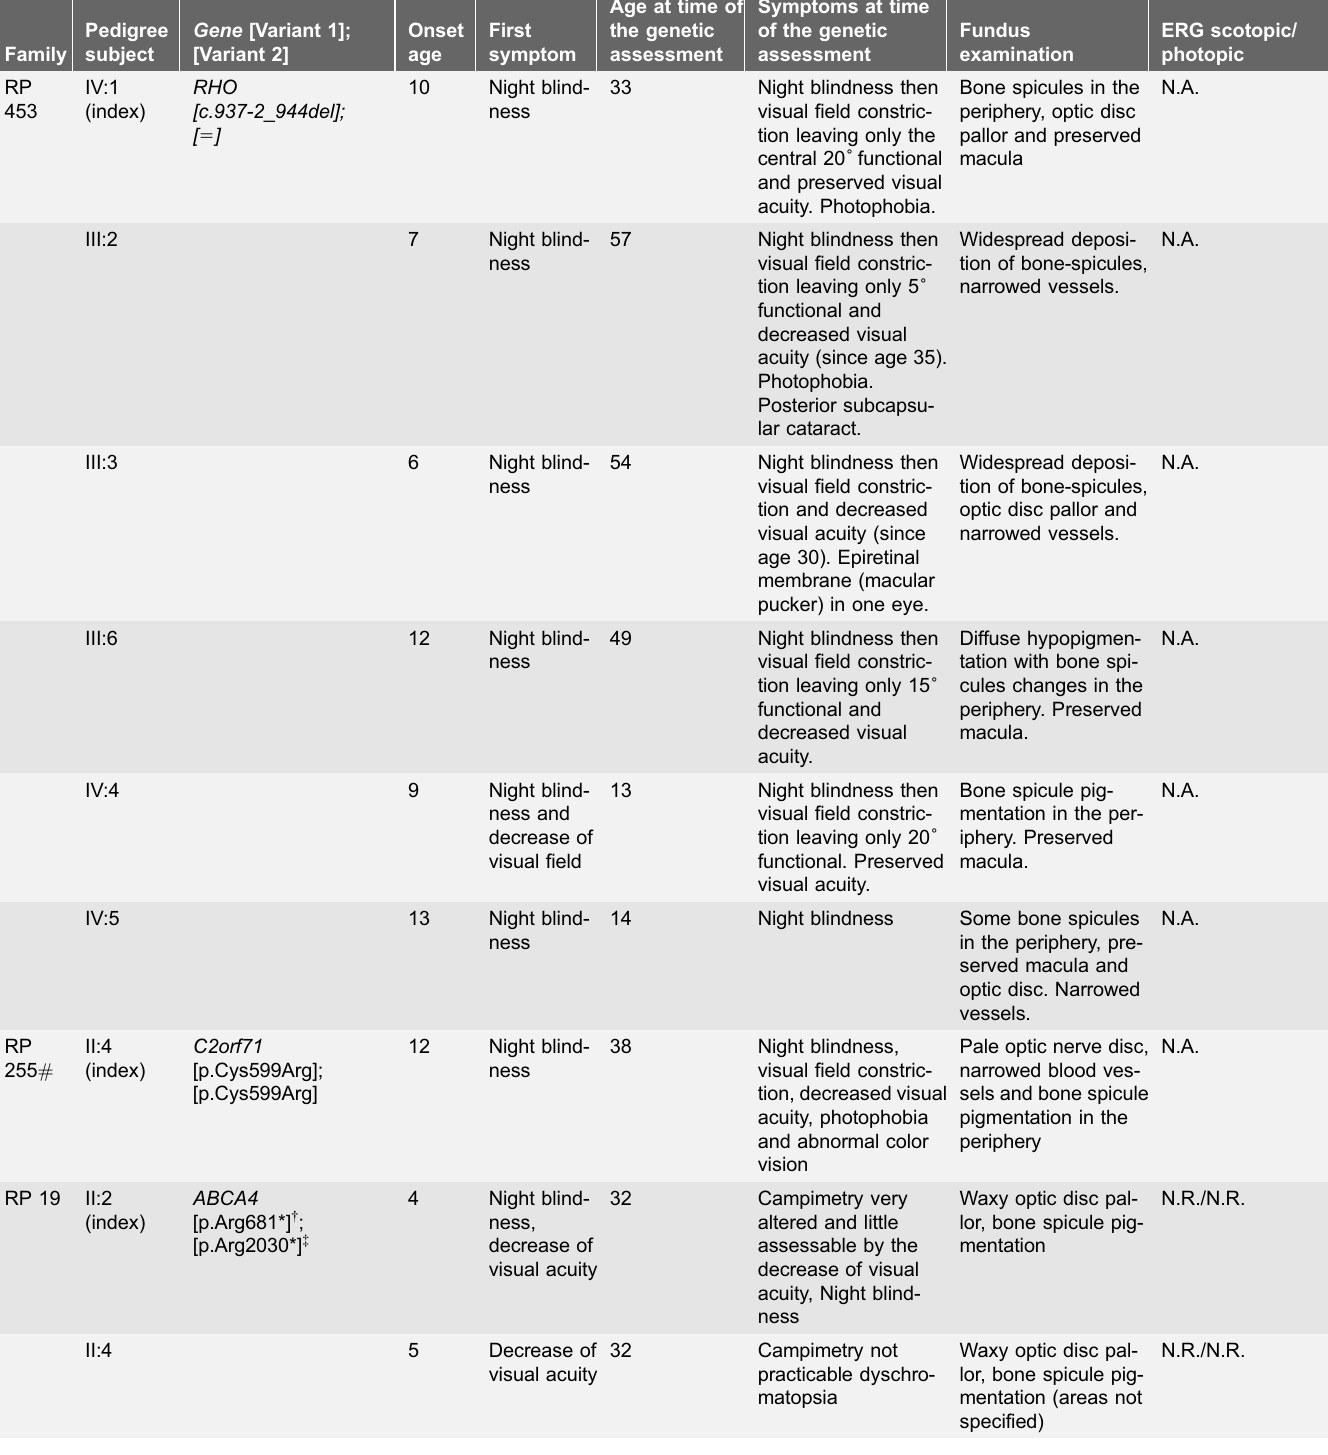
Table 1. Clinical characteristics of affected family